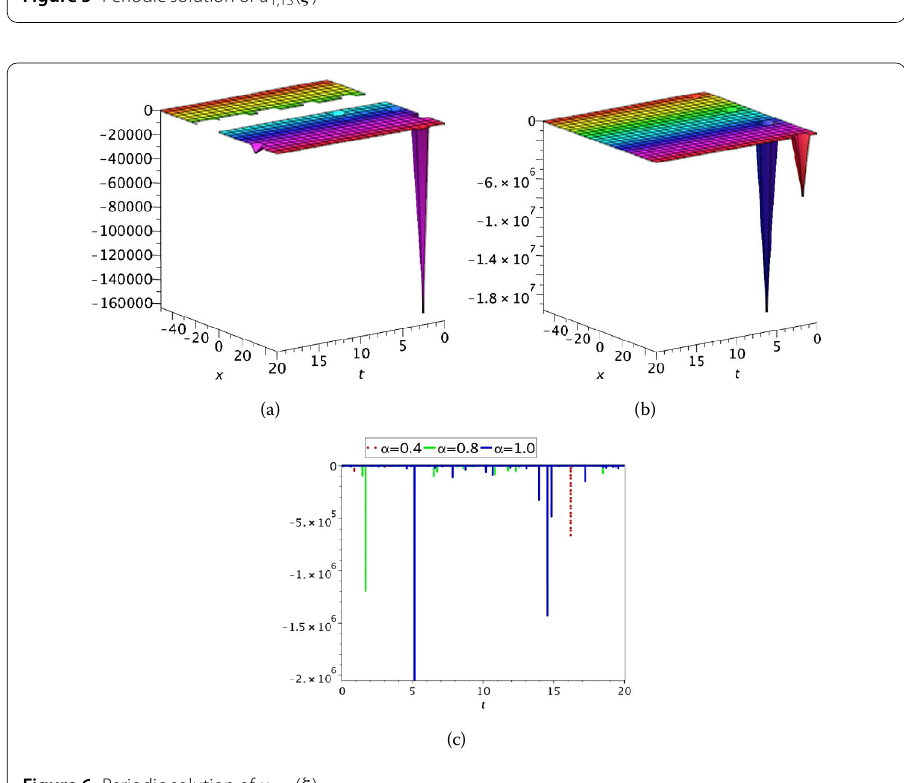
Figure 5 Periodic solution of u 1,13 ( ξ )